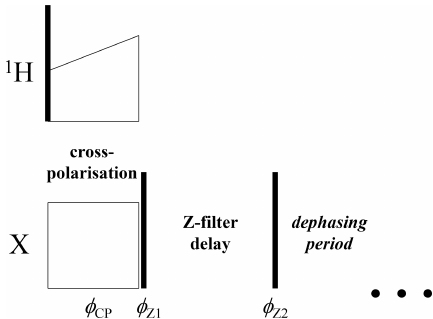
Figure 6. Initial part of the CODEX pulse sequence (Figs. 1 and 3) with the additional Z filter between the CP section and the dephas-